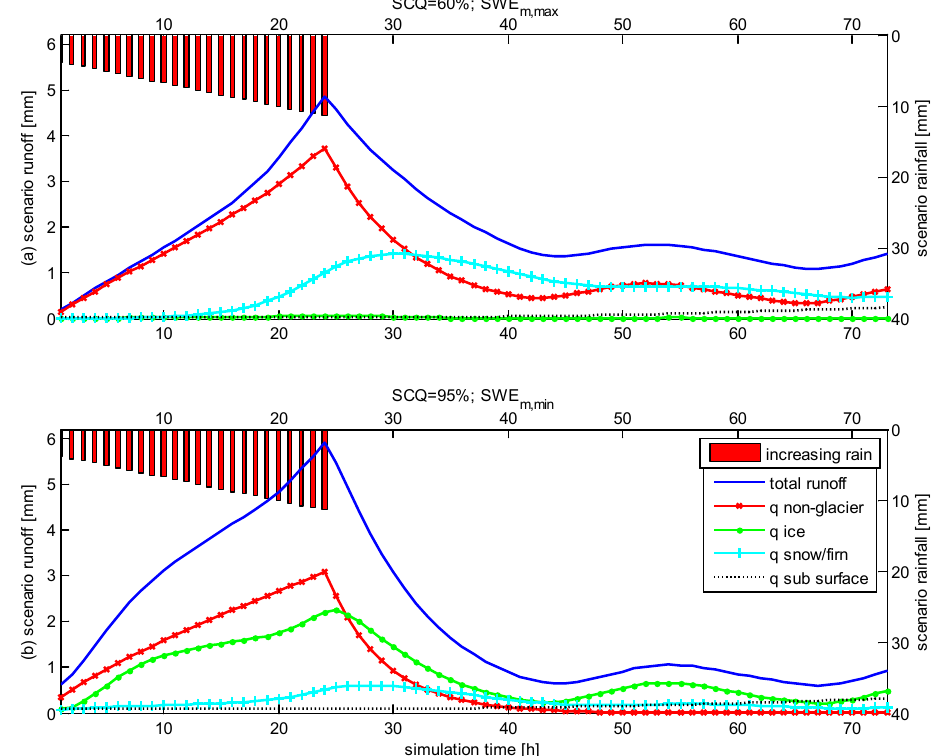
Fig. 8. Simulation results for Gepatschalm with a design storm ( T = 5000years, D = 24h) with increasing rainfall intensity and varying initial state conditions (a) 5 June 2006; SCQ=60% and SWE=SWE m , max (b) 3 October 1999; SCQ=95% and SWE=SWE m , min . Figure 8. Simulation results for Gepatschalm with a design storm (T=5000 years, D=24h) 2 with increasing rainfall intensity and varying initial state conditions (a) 5 June 2006; 3 capacity left. After the flood peak was reached, melt effects caused by positive temperatures starts. Runoff from the ice- SCQ=60 % and SWE=SWE (b) 3 October 1999; SCQ=95 % and SWE=SWE 4 m,max cascade plays only a minor role, since most parts of the glacierized areas are covered with a snow pack still having retention capacity left. Finally, the scenario hydrograph of SCQ = 95 % and SWE m , min (Fig. 8b) is also mainly induced by discharging rain as well as outflow from the ice